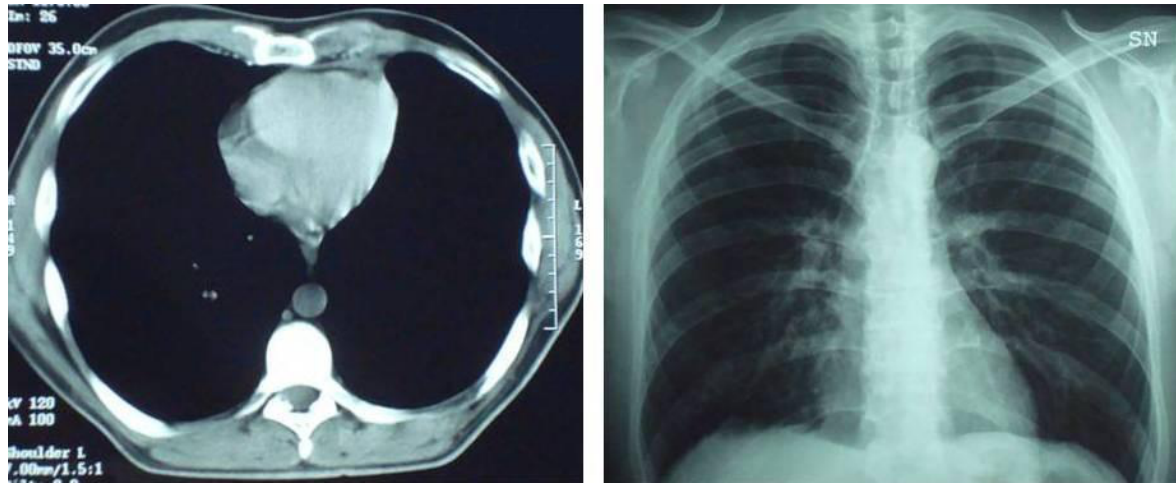
FIGURE 4. CT of the thorax and chest X-ray at 12 months showed maintenance of a normal anatomical position of the lung as well as the diaphragmatic